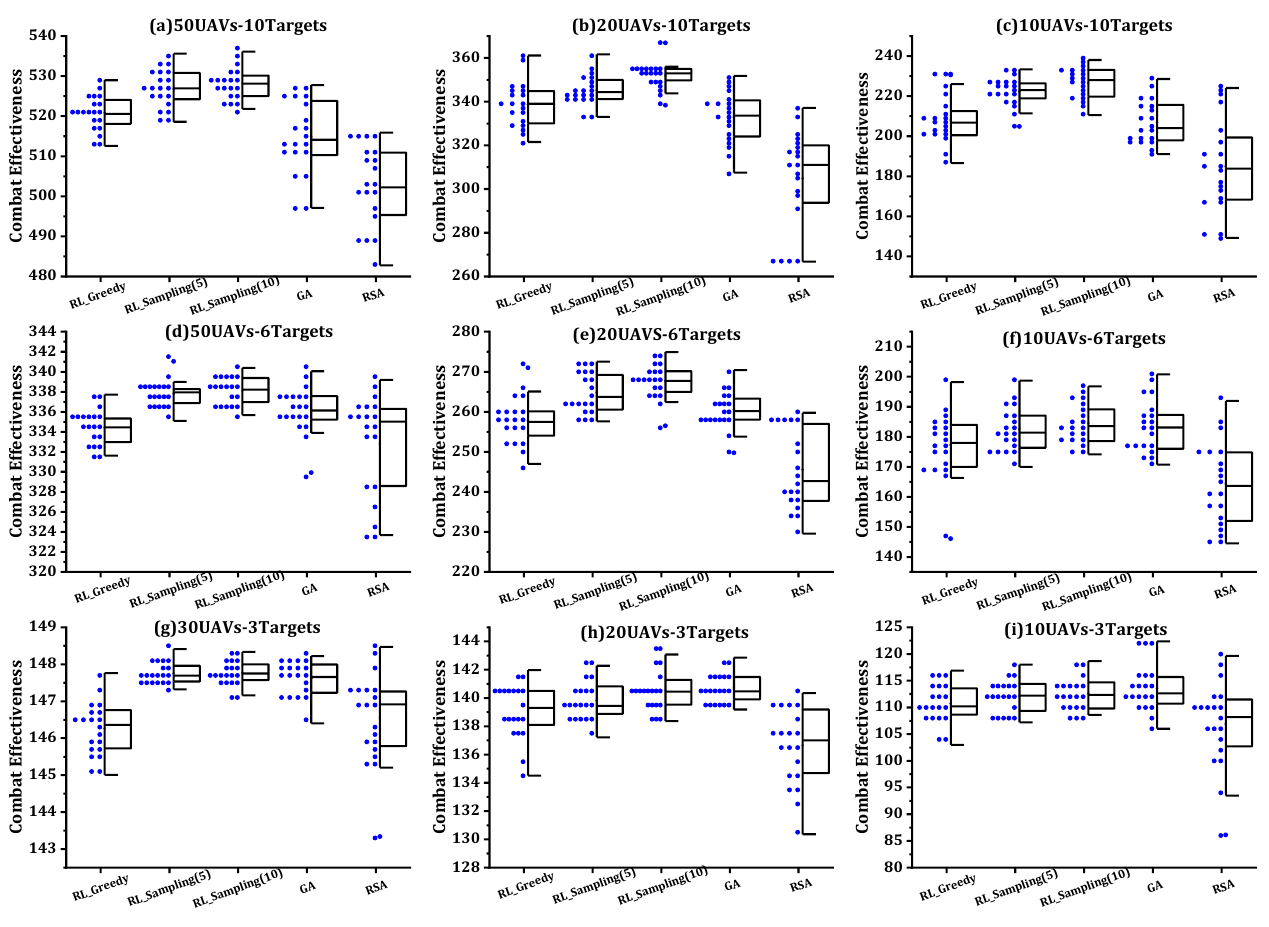
Figure 4. Performance comparison on solution